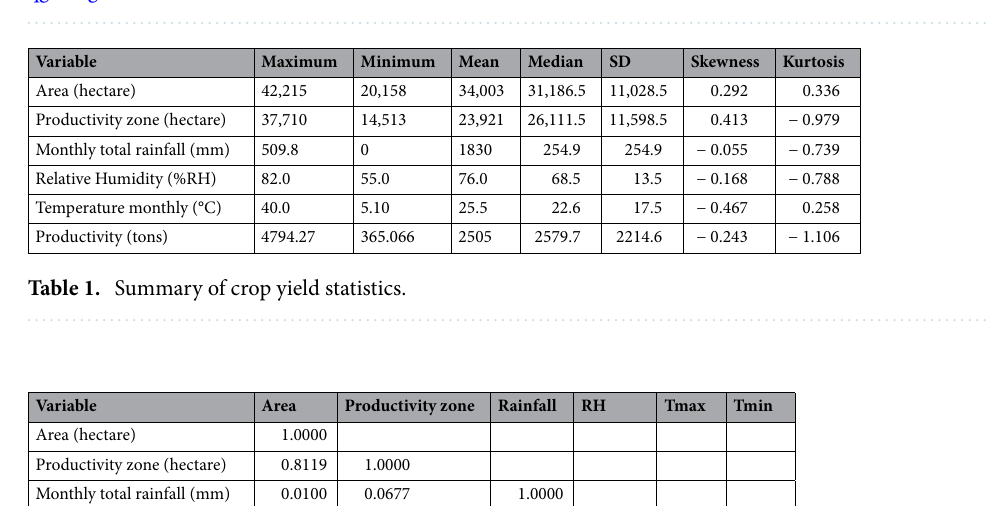
Figure 2. Coffee plantation area in Chiang Rai, Thailand. Figure has been generated by Mr. Yotsaphat Kittichotsatsawat, the first author of this manuscript using the Qgis program. Version 3.8.1. URL. https:// www. qgis. org/ en/ site/ index. html.